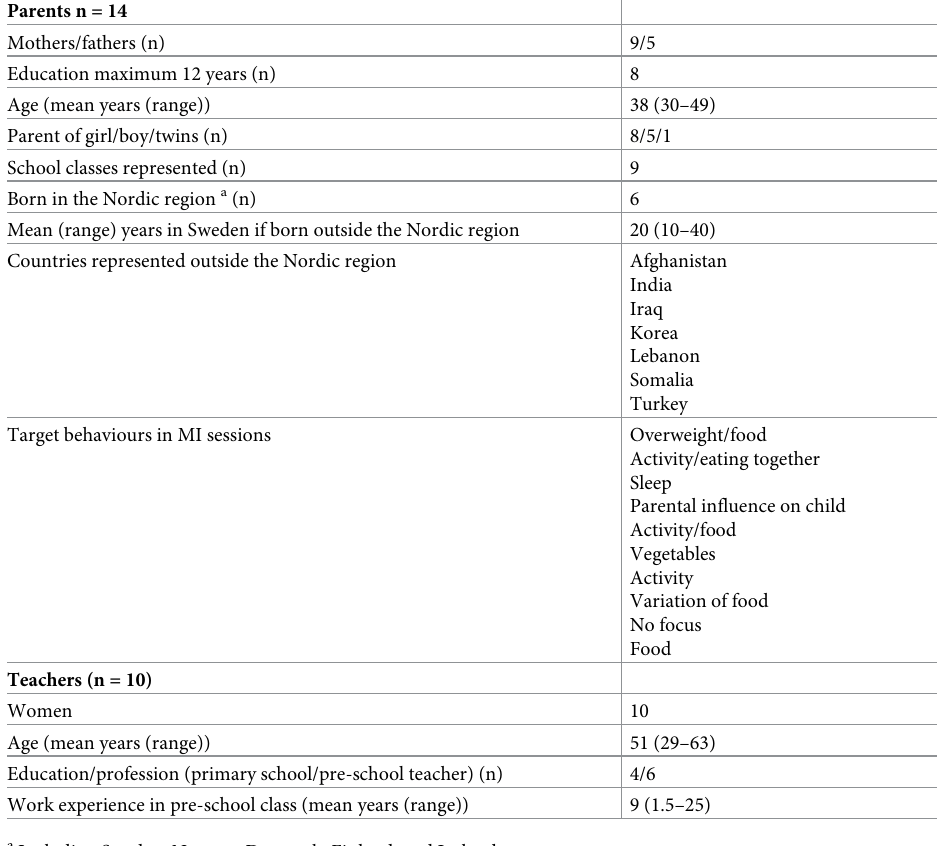
Table 1. Characteristics of participating parents and